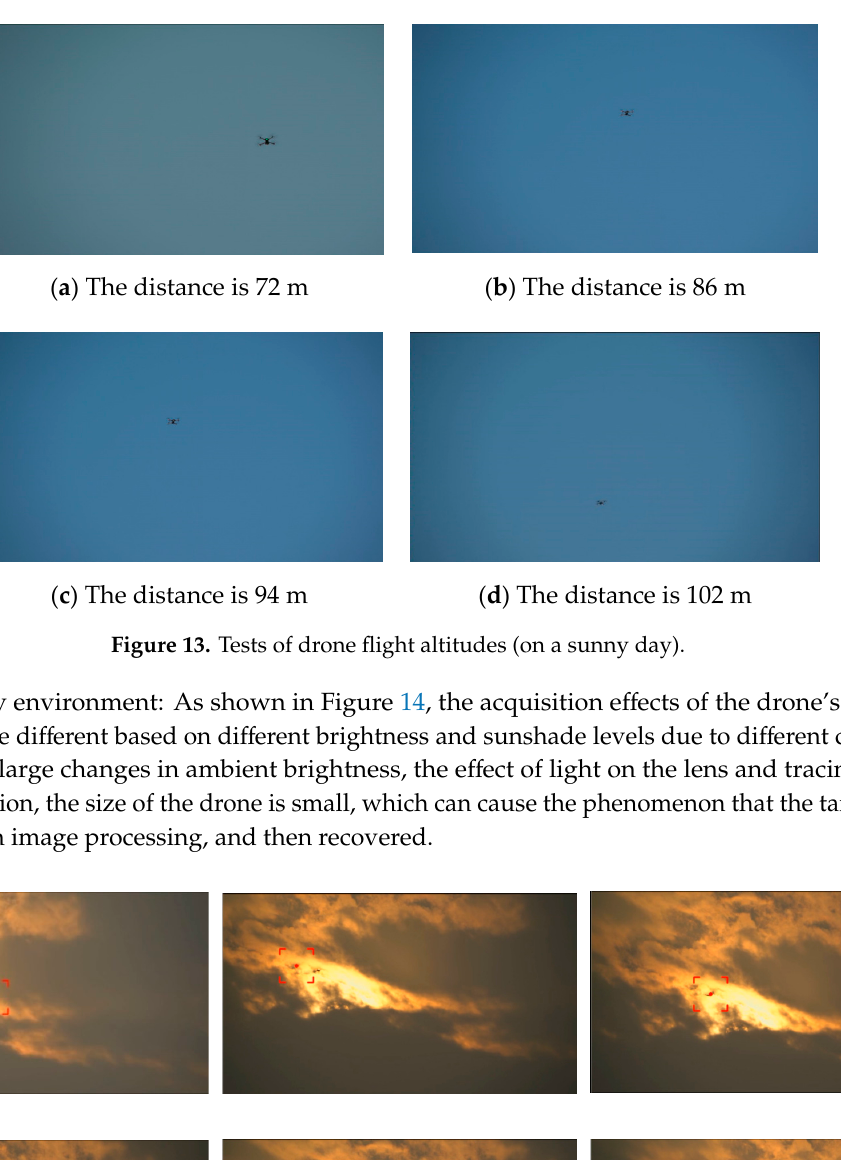
Figure 12. 3D simulation and physical circuit picture of the main control unit and motor control unit.